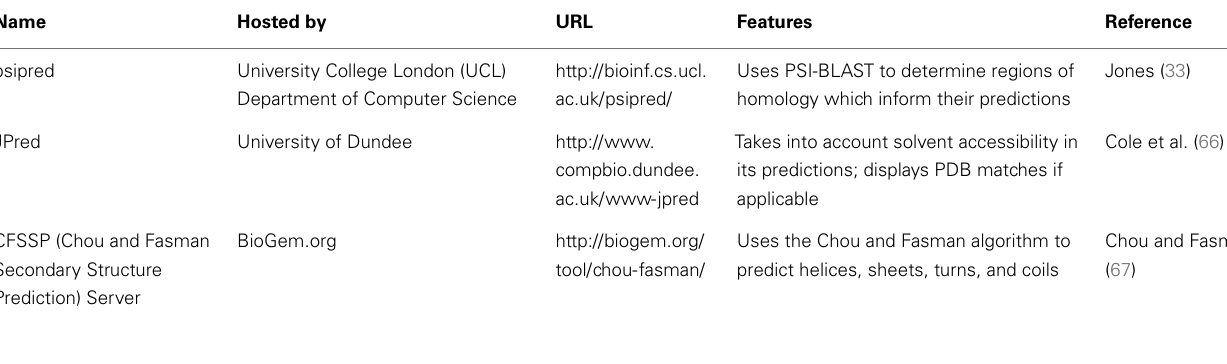
Table 4 |Tools for the prediction of secondary structure characteristics